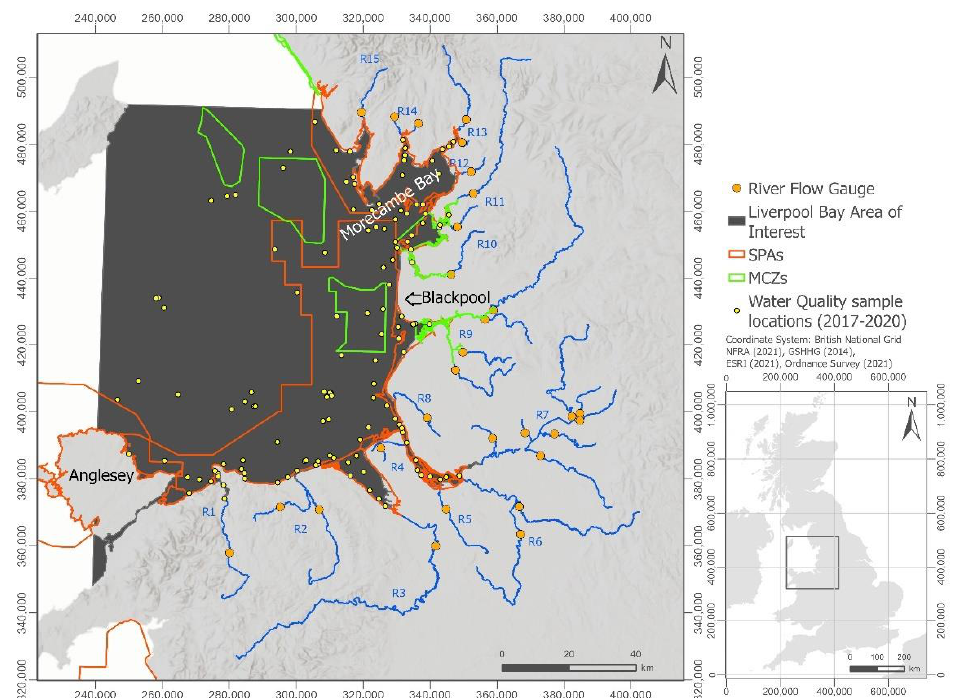
Figure 1. Location of Liverpool Bay and the river data used for the analysis. The orange circles show the positions of 29 gauges used to measure the river flow of the following rivers: R1 — Conwy, R2 — Clwyd and Elwy, R3 — Dee, R4 — Arrow Brook, R5 — Gowy, R6 — Dane and Weaver, R7 — Bollin, Glaze, Irk, Irwell, Medlock, Mersey and Sankey, R8 — Alt, R9 — Darween, Douglas, Ribble, Yarrow, R10 — Wyre, R11 — Lune and Conder, R12 — Keer, R13 — Bela and Kent, R14 — Crake and Leven, R15 — Duddon. Green and orange polygons denote Special Protection Areas (SPAs) and Marine Conservation Zones (MCZs).